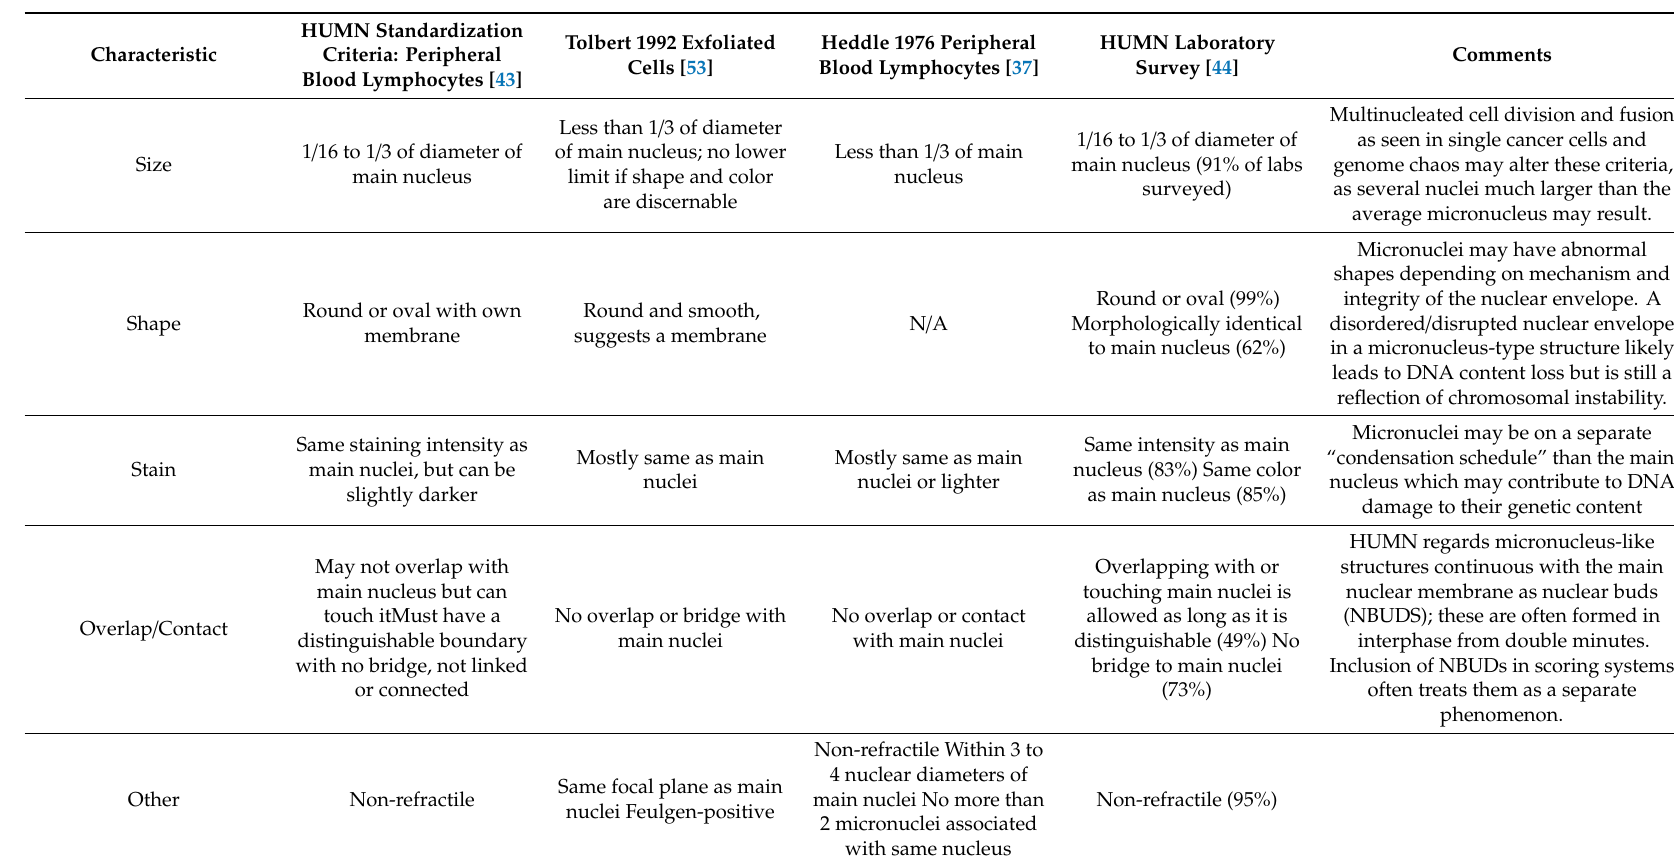
Table 2. Comparison of Scoring Criteria for the Micronuclei Test. Several inclusion criteria for counting micronuclei to determine frequencies during a micronucleus test, primarily in genotoxicity analysis. While these criteria are e ff ective in reducing false positives and work well for the CBMN-Cyt protocol in validated tissue types, they may not be universally applicable to all cell types (especially with the high variance found in cancer cells). Additionally, many traits beyond micronucleus frequency have not been thoroughly investigated, especially in regard to usefulness as a biomarker of chromosomal